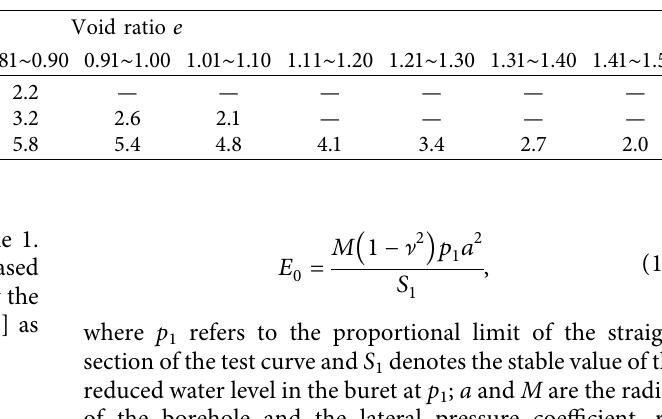
Table 2: The relationship between β and e .